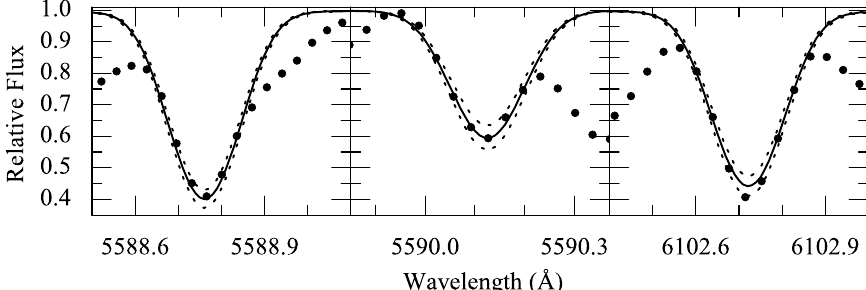
Fig. 14. Three Ca I lines in the spectrum of HD 209621. The synthetic profiles are given for the calcium abundance log ϵ (Ca) = 4.94 ± 0.15. Seven clean Ca I lines were selected and abundance calculations on the basis of equivalent widths give the mean calcium abundance log ϵ (Ca) = 4.94 ±